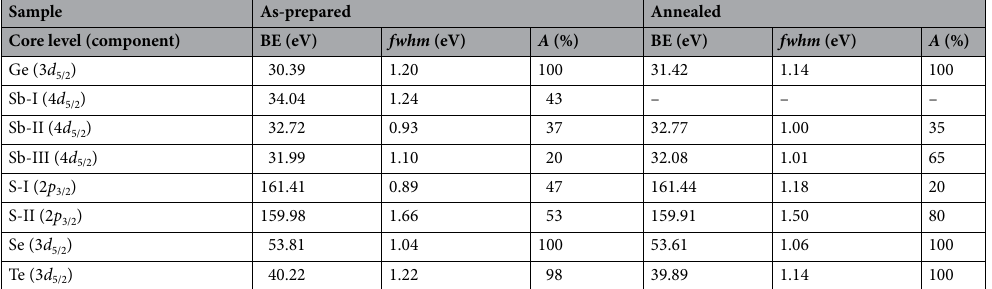
Table 1. Best fit values of characteristic parameters for XPS core level peaks. The binding energy (BE) position, full width at half maximum ( fwhm ) and area ( A ) of the doublets’ main components are shown for Ge, Sb, S, Se and Te core levels, obtained through the fitting of experimental XPS spectra of as-prepared and annealed at 175 °C films.